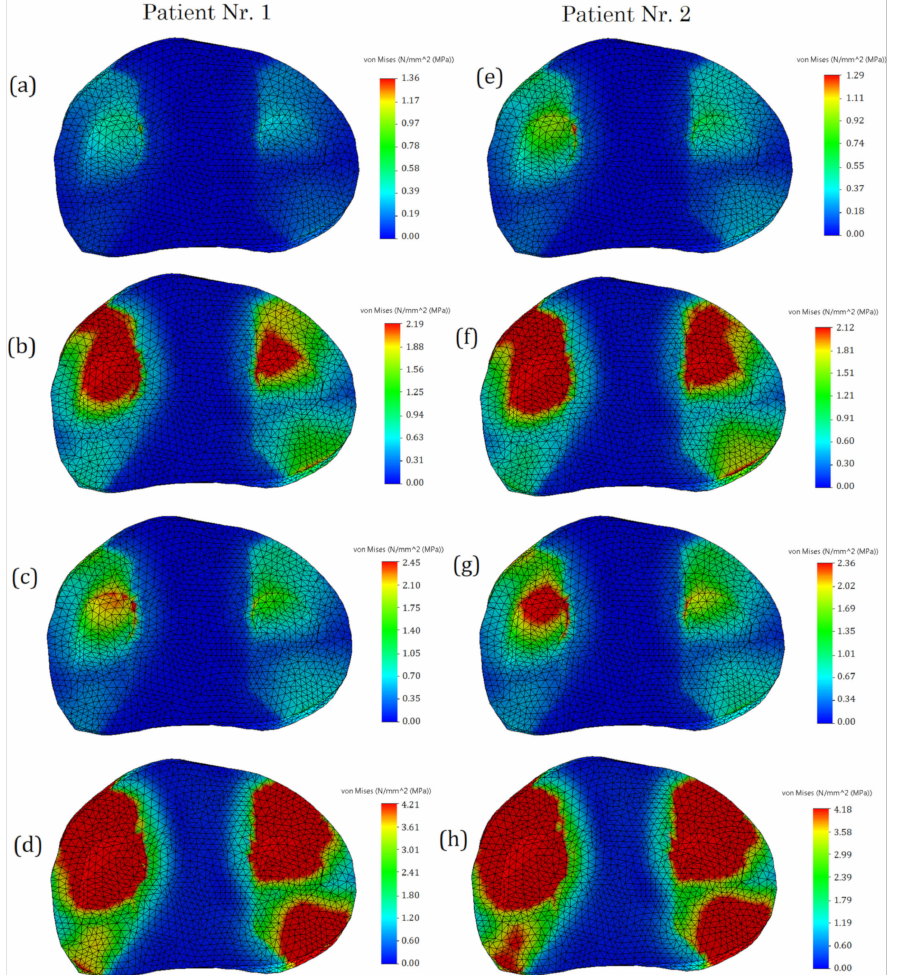
Figure 9. Von Mises stress on tibia cartilage: ( a , e )—undamaged meniscus; ( b , f )—meniscus with a longitudinal tear; ( c , g )—meniscus with a radial tear; ( d , h )—meniscus with a complex